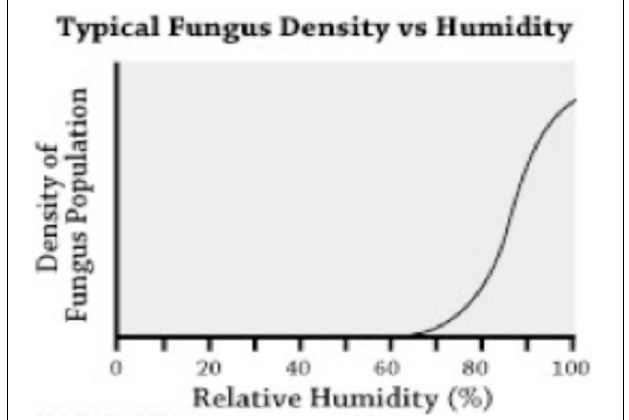
FIGURE 1 | Typical fungus density vs. humidity.